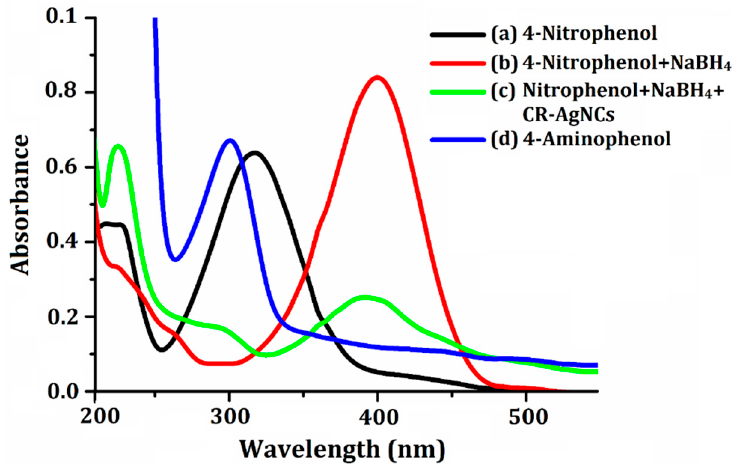
Figure 10. UV-Vis spectra of 4-nitrophenol (a), reduction of 4-nitrophenol with NaBH 4 (i.e., 4-nitrophenolate ion) (b), reduction of 4-nitrophenol with NaBH 4 and CR-AgNCs (c) and formation of 4-aminophenol (d).